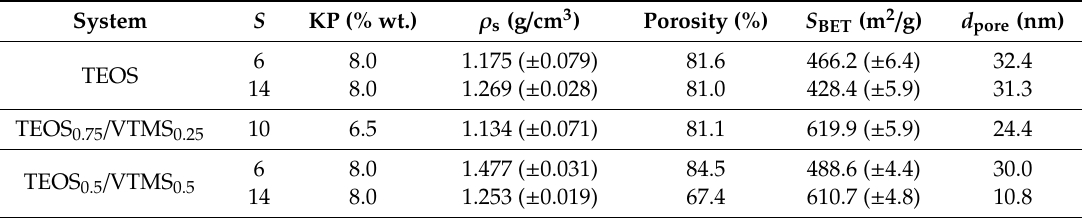
Table 2. Properties of KP-reinforced silica aerogel composites obtained by He pycnometry and nitrogen gas